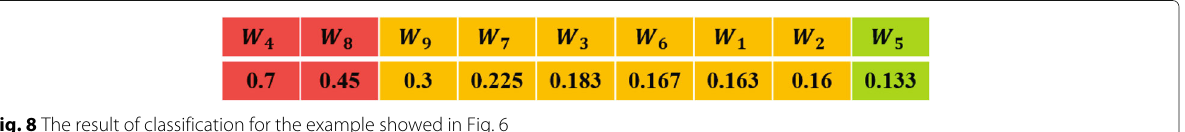
distributed. Take Fig. 10 as an example, where k = 2.